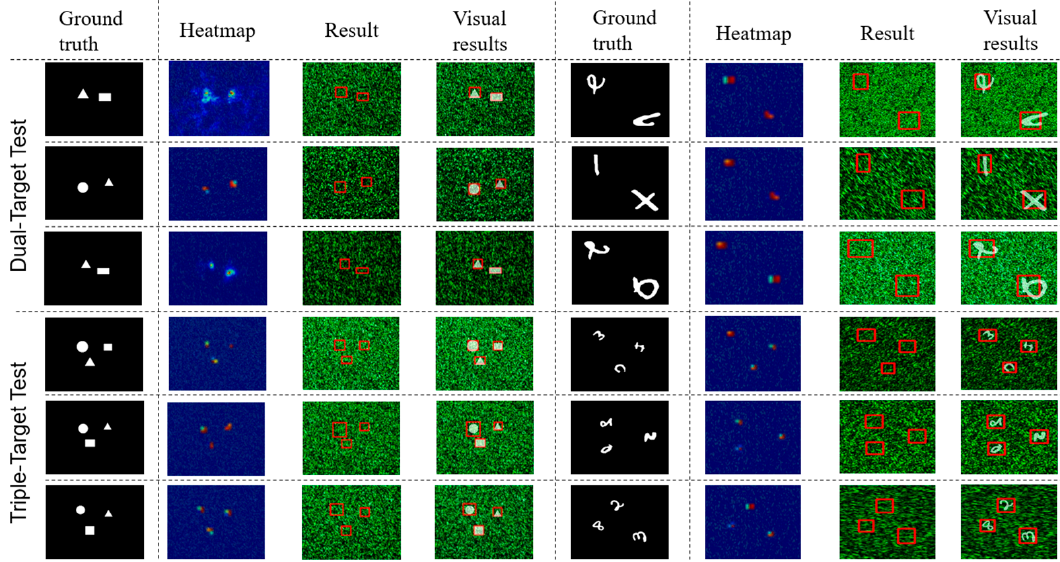
Figure 10. Results for multitarget testing obtained by adding a small amount of multitarget data for training. The red box represents the target location results output by the model. To better evaluate the prediction accuracy of the proposed model, the aforementioned evaluation indices were used. The P–R curves are shown in Figure